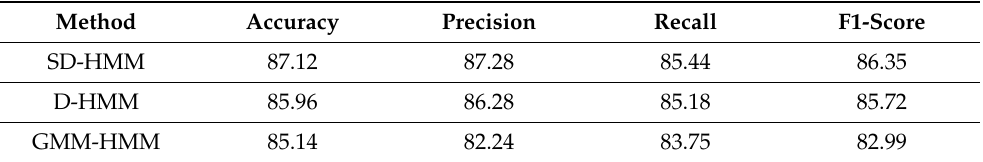
Table 4. Model performance evaluation results for the second dataset.